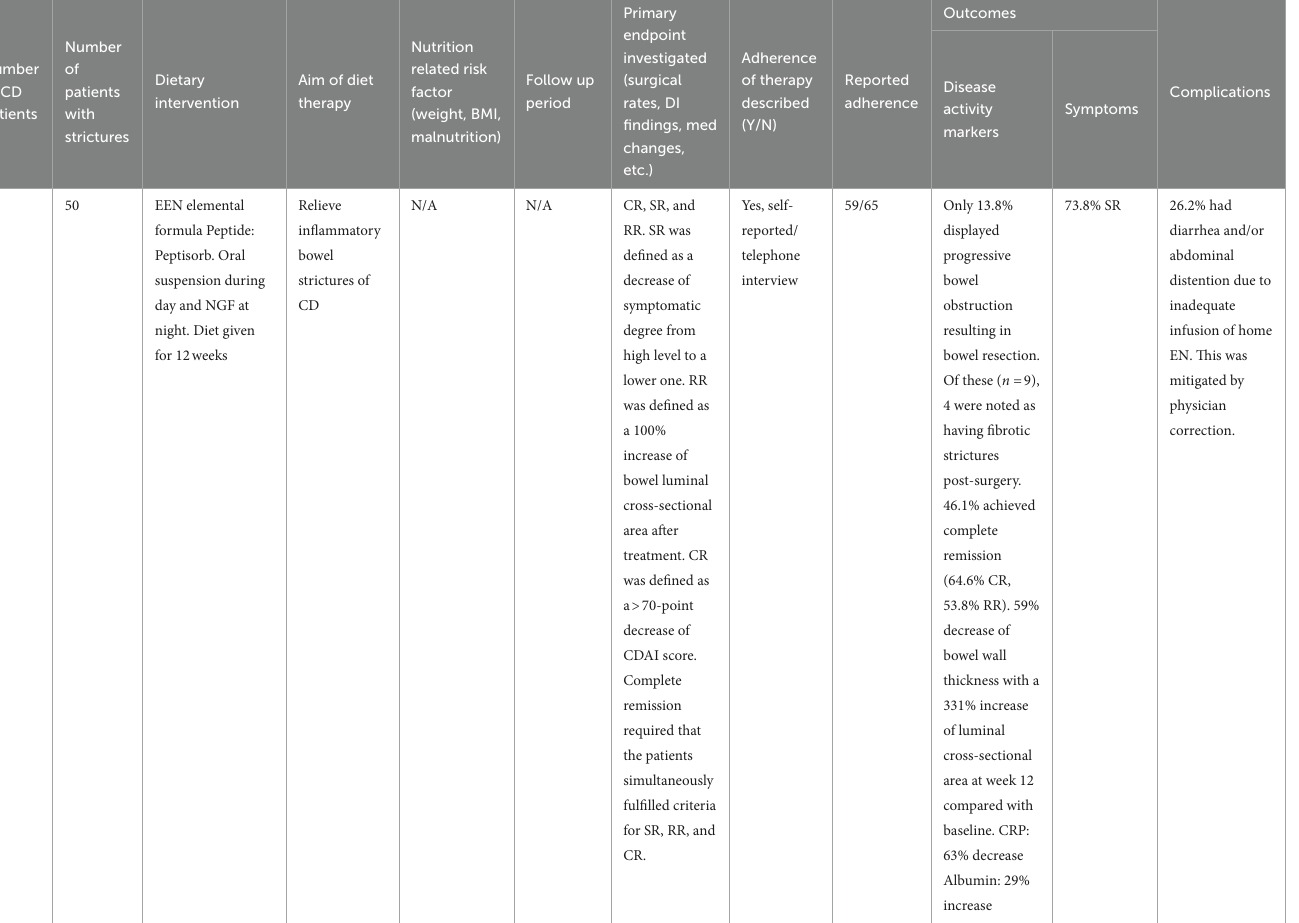
TABLE 1 Summary of study details from literature review of dietary interventions in fibrostenotic Crohn’s